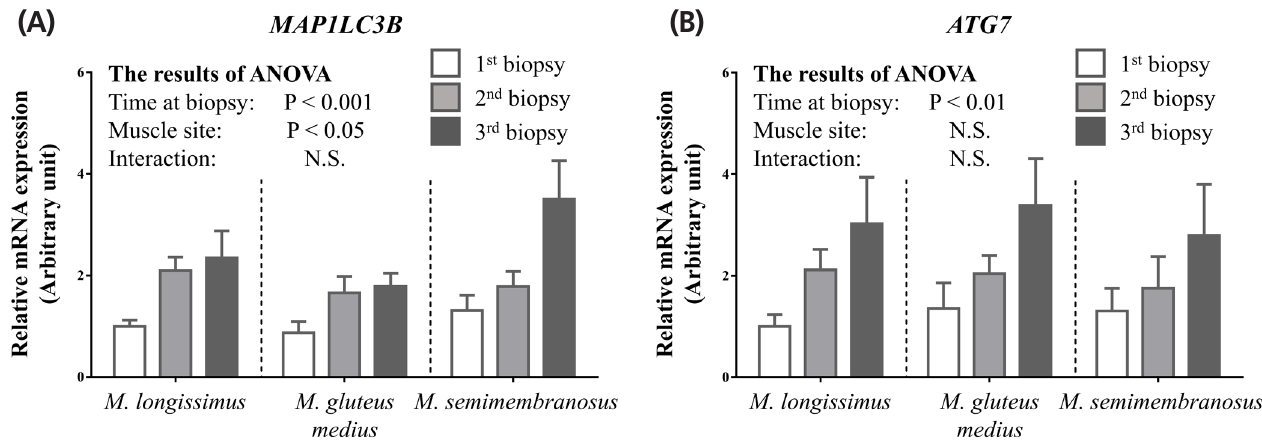
Figure 2. Effects of the fattening stage on expression of genes associated with autophagy in M. longissimus, M. gluteus medius, and M. semimembranosus of Japanese Black cattle. After skeletal muscle biopsy, mRNA expression of MAP1LC3B (A) and ATG7 (B) was measured by quantitative reverse-transcription polymerase chain reaction. The data (total n = 54 for each gene: six cattle×three time points×three muscle sites) are analyzed by comparing groups using a two-way analysis of variance (factor: time at biopsy and muscle site) and are expressed as means±standard error of the mean. Statistical significance was defined as p<0.05. MAP1LC3B, microtubule-associated protein 1 light chain 3 β ; ATG7, autophagy related 7.